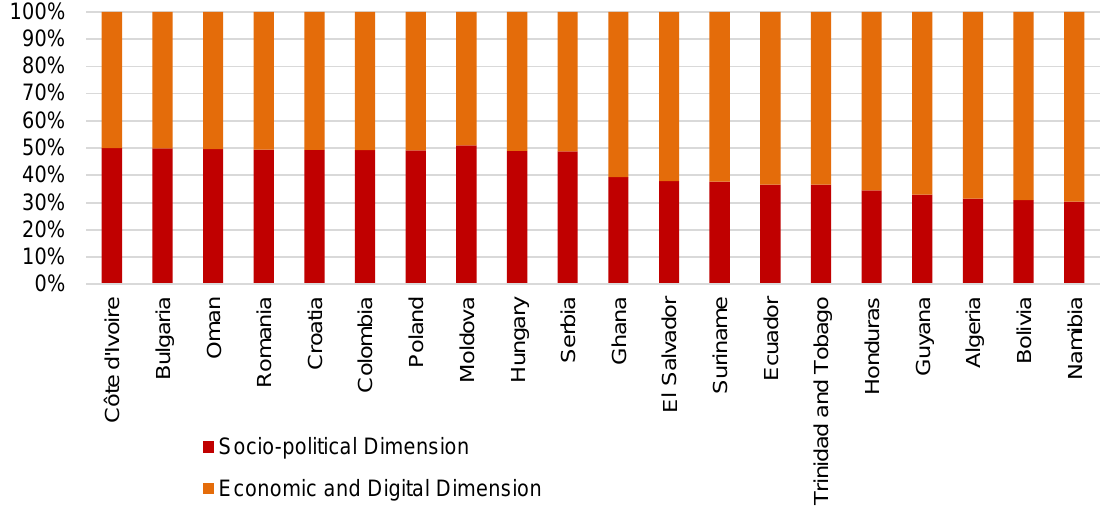
Figure 7. Balancing composite target pairs of economic, social, political, and digital capability and